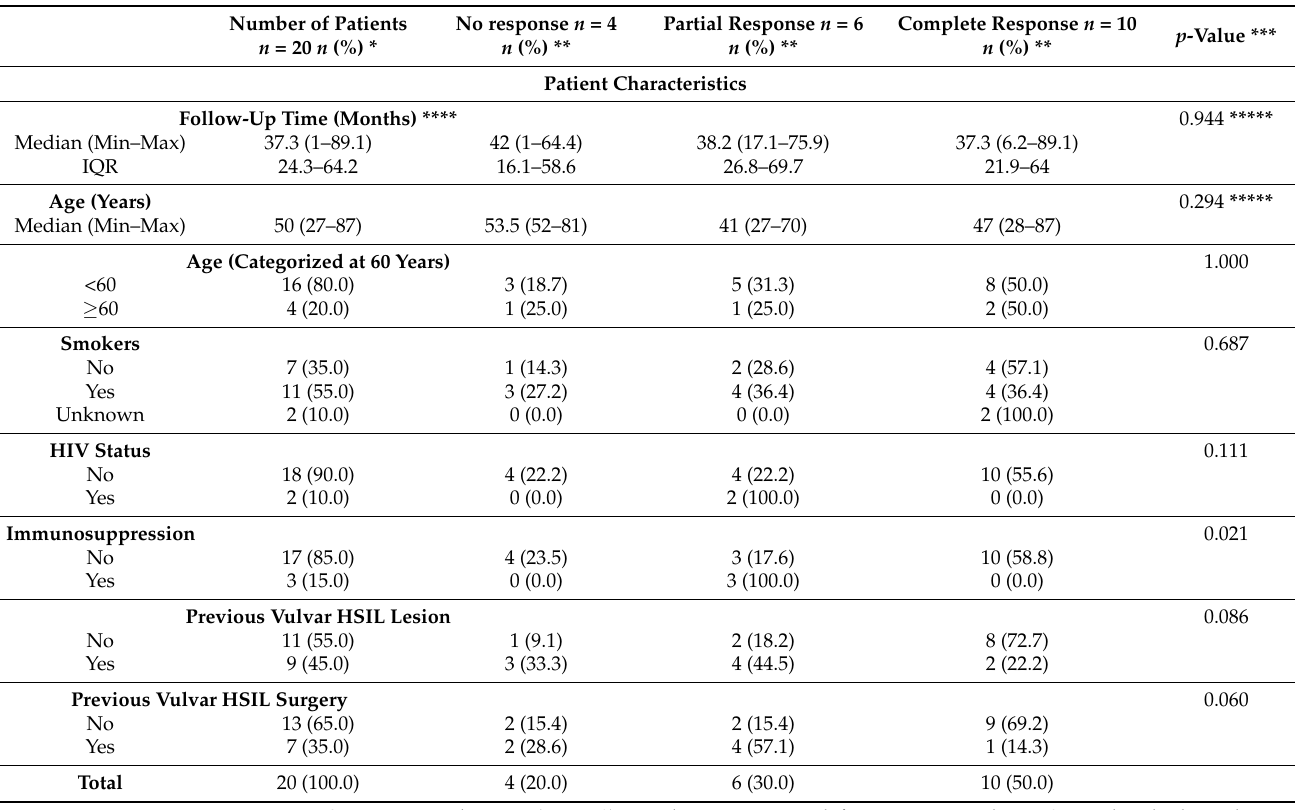
Table 1. Follow-up time and patient characteristics. Patients treated with imiquimod for vulvar high-grade squamous intraepithelial lesion (vulvar HSIL).